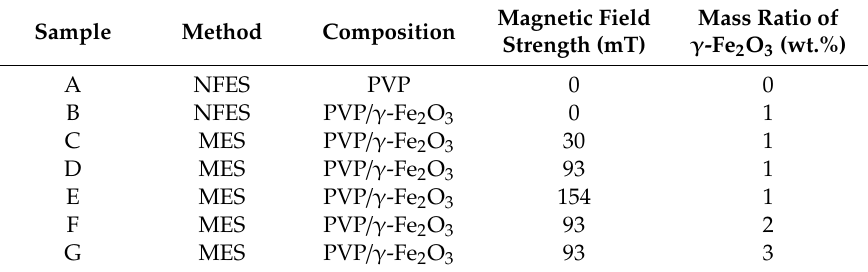
Figure 1. ( a ) A schematic illustration of the magnetic-electrospinning (MES) setup. Theoretical simulations of electric-magnetic fields ( b – f ) in the MES share the same voltage (2 Kv) but di ff erent distances (4, 8, and 14 cm) and magnetic field strengths (30, 93, and 154 mT); ( b ) 4 cm and 93 mT; ( c ) 8 cm and 93 mT; ( d ) 14 cm and 93 mT; ( e ) 8 cm and 30 mT; and ( f ) 8 cm and 154 mT. The X-axis and the left Y-axis of ( b – f ) indicate the distance in cm, and the color bar of the right Y-axis indicates the magnetic field strength ( H ) in A / m. Table 1. Detailed information for each